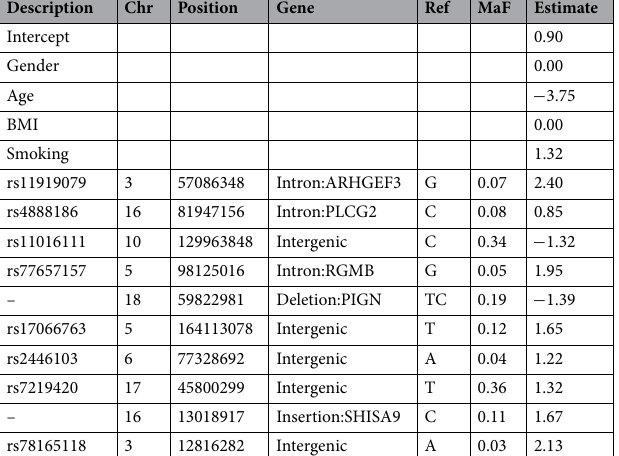
Table 2. Polygenic risk model learned from colorectal cancer data. Presented results include the chromosome (Chr) and position of the significant genetic variants, the gene they lie on (Gene), reference allele (Ref), minor allele frequency (MaF), and estimated effect